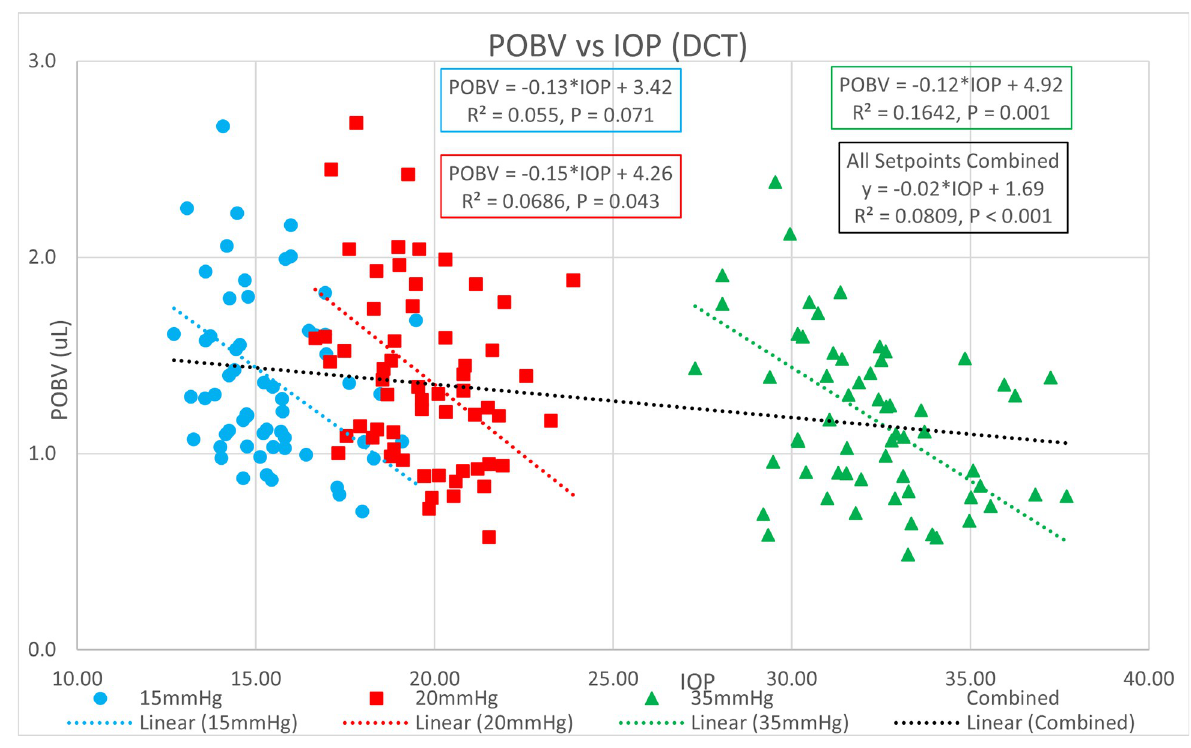
Fig 5. Negative correlation of POBV to IOP for DCT measurements.